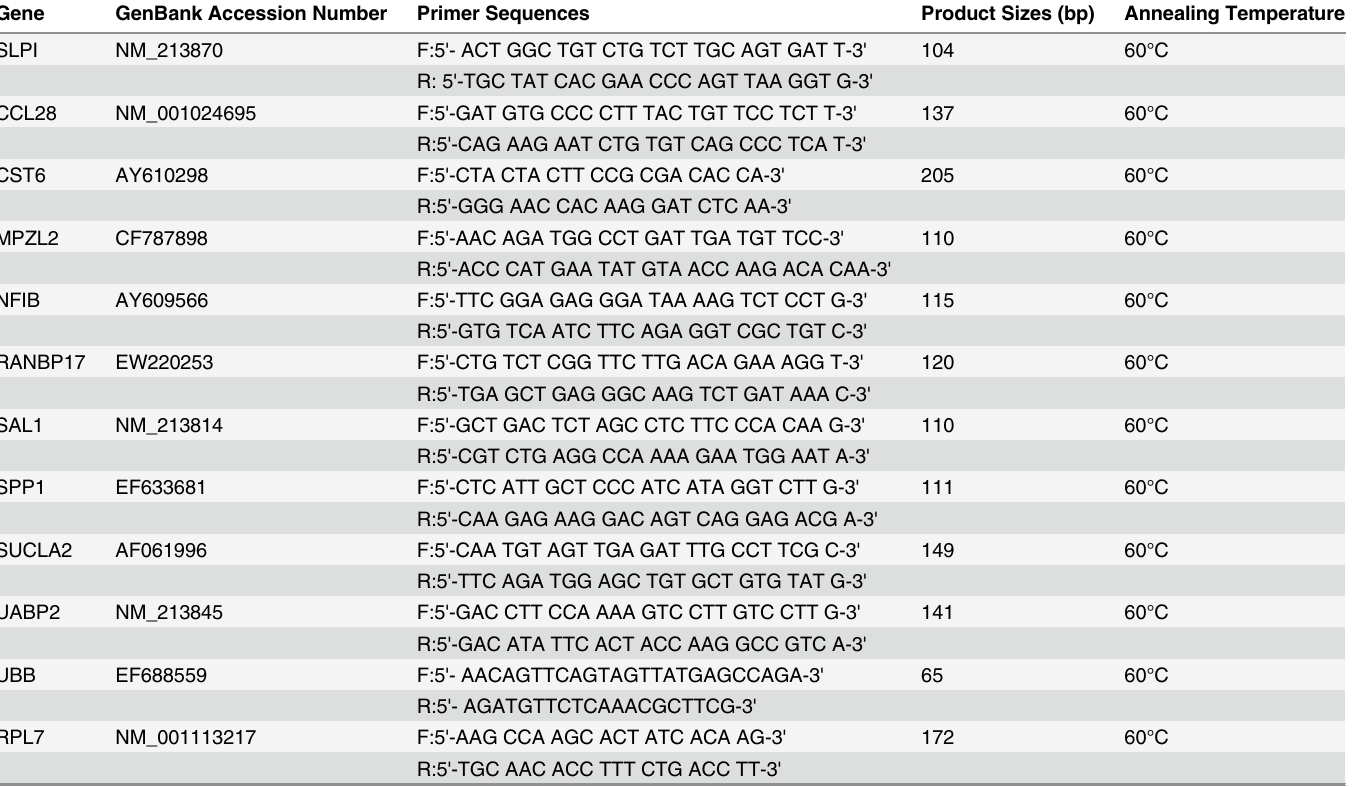
Table 1. Primer sequences used for real-time RT-PCR.